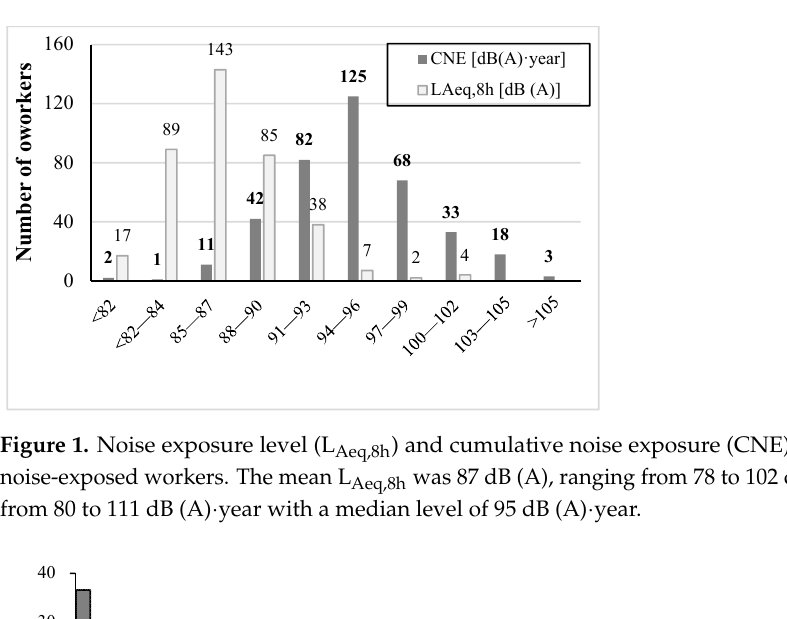
Figure 1. Noise exposure level (L Aeq,8h ) and cumulative noise exposure (CNE) distribution of the noise-exposed workers. The mean L Aeq,8h was 87 dB (A), ranging from 78 to 102 dB (A); CNE ranged from 80 to 111 dB (A)·year with a median level of 95 dB (A)·year.